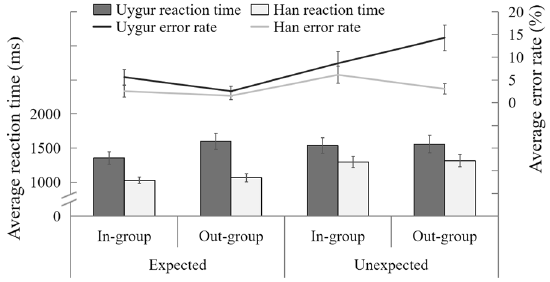
Fig. 2 Average reaction time and the error rate of Uygur and Han Ethnicity under different task conditions in self/other differentiation